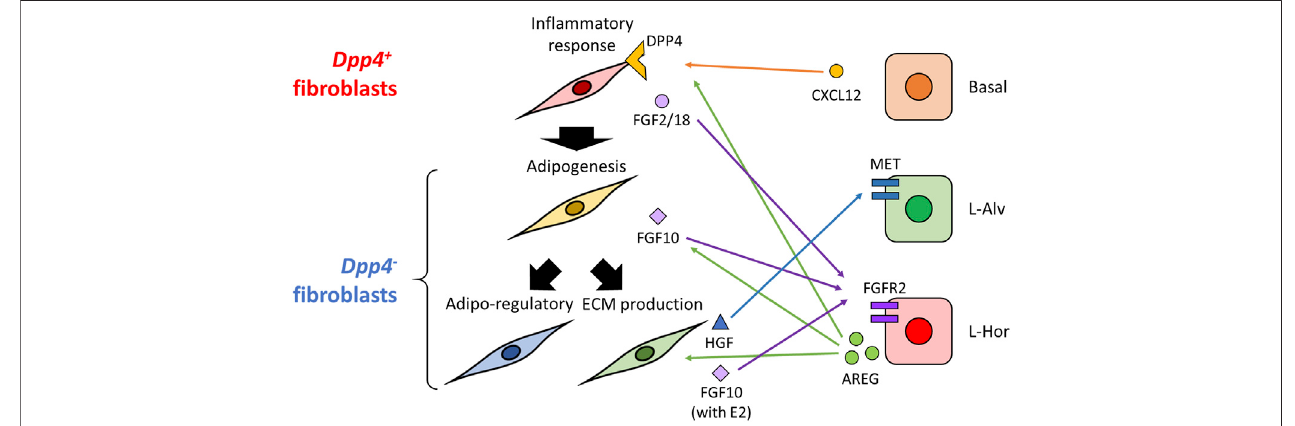
FIGURE7| Graphicalabstractofthisstudy.Inthepresentstudy,weidenti fi edtwomajortypesofmousemammarygland fi broblasts: Dpp4 + and Dpp4 - fi broblasts. Theyeachshoweddiscretegeneexpressionpro fi lesasindicatedinthis fi gure(e.g.,in fl ammatoryresponseinthe Dpp4 + fi broblasts),aswellasdistinctlocalizationwithin the mouse mammary gland. Estrogen induced gene expression changes in a population-speci fi c manner, without distinct activation of typical estrogen-regulated gene expressions. Trajectory analysis indicated a directional differentiation from the Dpp4 + fi broblasts towards the subclusters of the Dpp4 - fi broblasts as indicated by thick black arrows on the left. Cell-cell interaction inference suggested potential interactions with certain subtypes of mammary epithelial cells (e.g., AREG-EGFR, CXCL12-DPP4, MET-HGF or FGFR2-FGF2/10/18; indicated by the colored arrows).